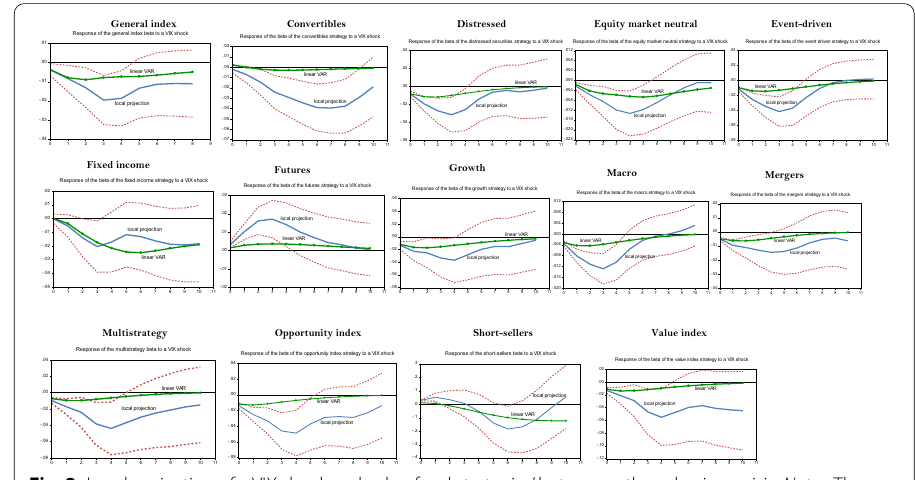
Fig. 2 Local projection of a VIX shock on hedge fund strategies’ betas over the subprime crisis. Notes: The impulse response functions corresponding to the linear LP are built using the Jordà’s (2004, 2005, 2009) algorithm provided by Eren Ocakverdi, consultant at Yapy Kredi. The local projection of a beta strategy is performed over the subprime crisis (2007Q3–2009Q4). We also provide the linear VAR estimated over the whole sample period selected as benchmark. The confidence interval of the LP impulses, computed at the threshold of 95%, is in dotted lines. As explained in the paper, our model comprises five endogenous shocks, placed in the following order to perform the Cholesky factorization (Sims 1980) required to build structural shocks: GDP growth, term spread, credit spread, beta (own shock), and VIX. As usual, these variables are ordered by increasing level of endogeneity. This order relies on the conventional information criteria: Akaike and Schwartz criteria. The long‑short credit strategy is excluded since its IRF is not enough